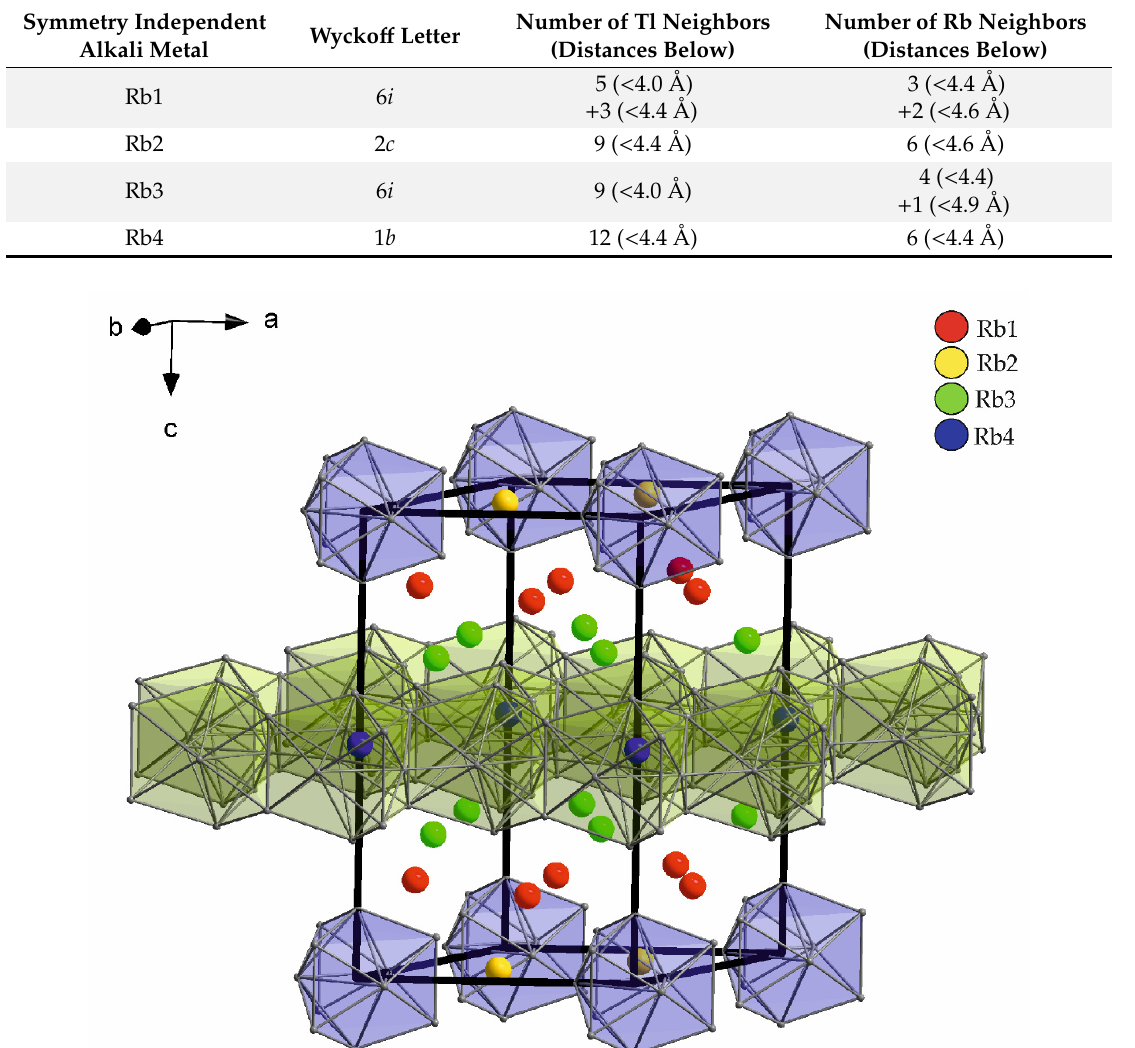
Table 4. Surrounding atoms of the symmetry inequivalent potassium positions in Rb 15 Tl 27 (space group P- 62 m ).